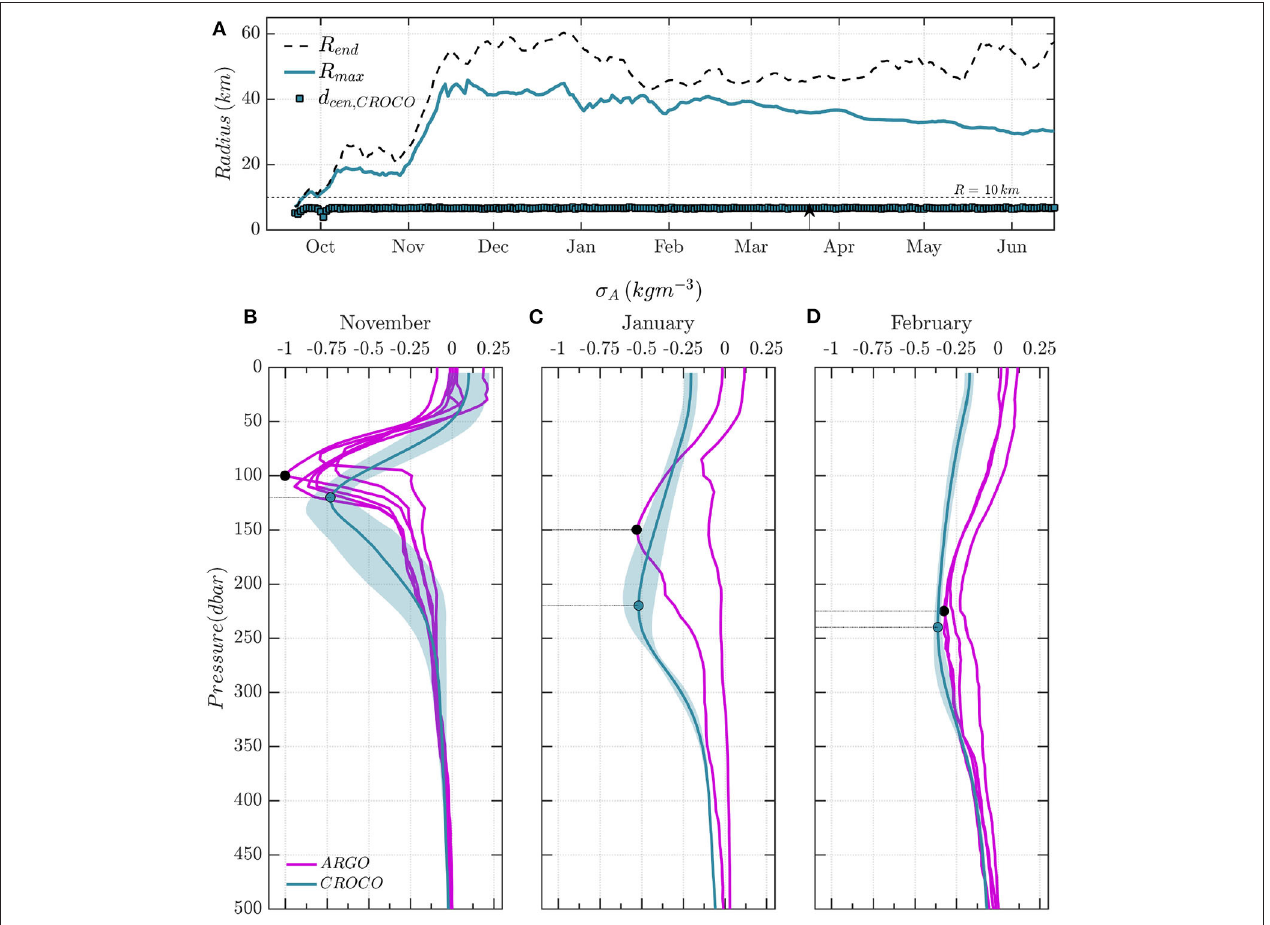
FIGURE 8 | (A) Temporal evolution of the M_IE15 eddy characteristic contour (solid line) and the last contour (black dashed line) computed with AMEDA algorithm applied on CROCO geostrophic fields. Vertical profiles of density anomaly σ A ( kgm − 3 ) for the months of (B) November 2015, (C) January 2016, and (D) February 2016 as obtained from the Argo float profiles that were trapped in the O_IE15 (shown with magenta color) and as obtained from the M_IE15 in CROCO-MED60v40-2015 simulation for the same period (shown with the blue